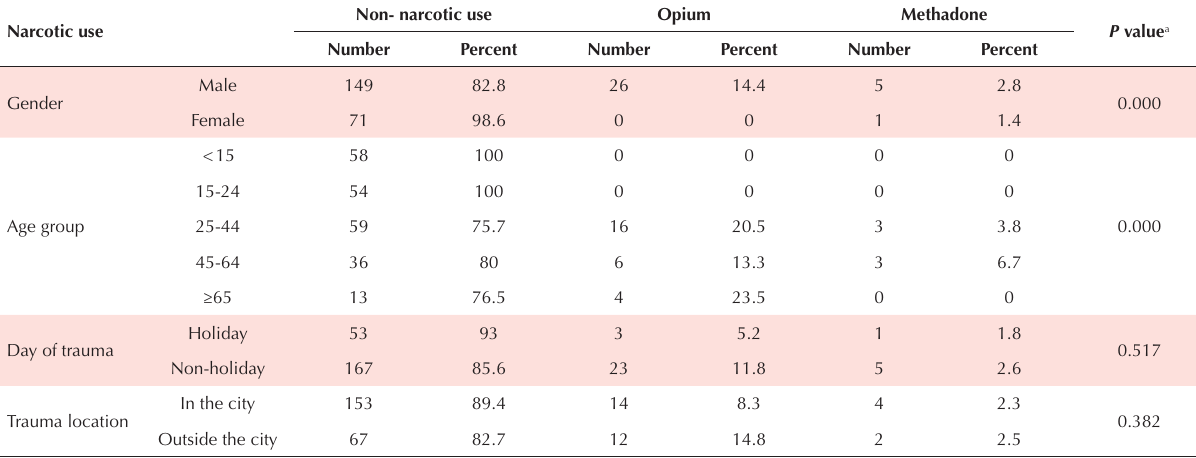
Non- narcotic use Opium